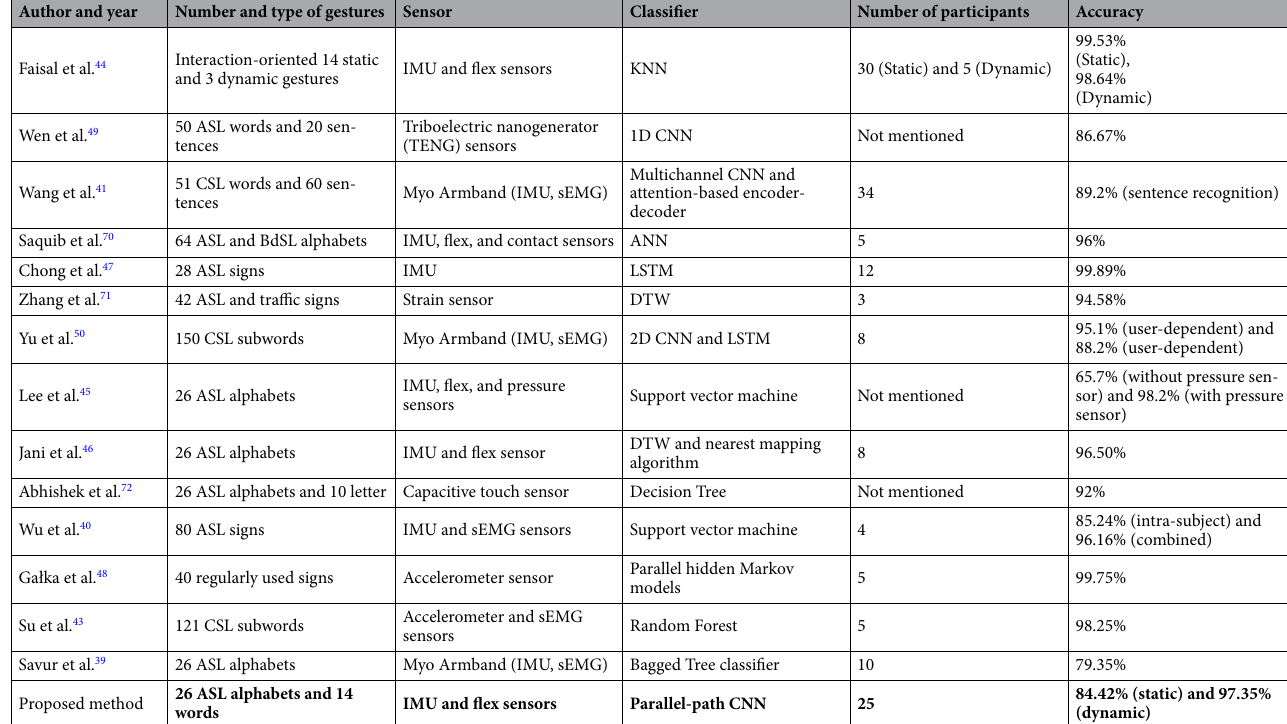
Table 4. Comparison of sensor-based hand gesture recognition